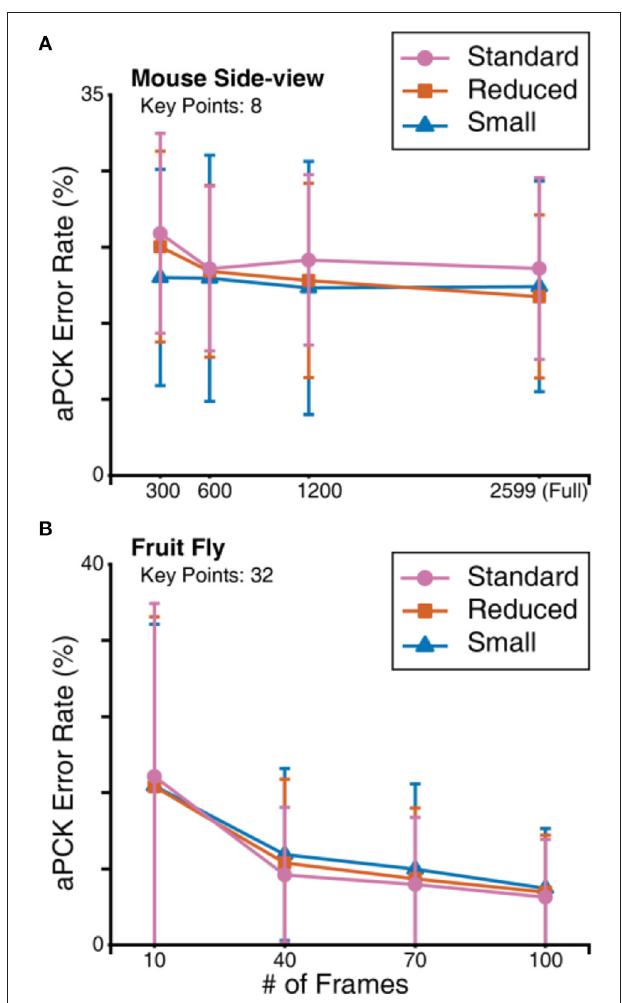
FIGURE 7 | FlexibleBaseline model size evaluation. (A) Prediction aPCK error rate on sampled mouse side-view dataset. (B) Prediction aPCK error rate on sampled fruit fly dataset. To simulate hardware constraints, all mouse side-view models were trained for 40,000 steps at a batch size of 10, and all fruit fly models were trained for 8,000 steps at a batch size of